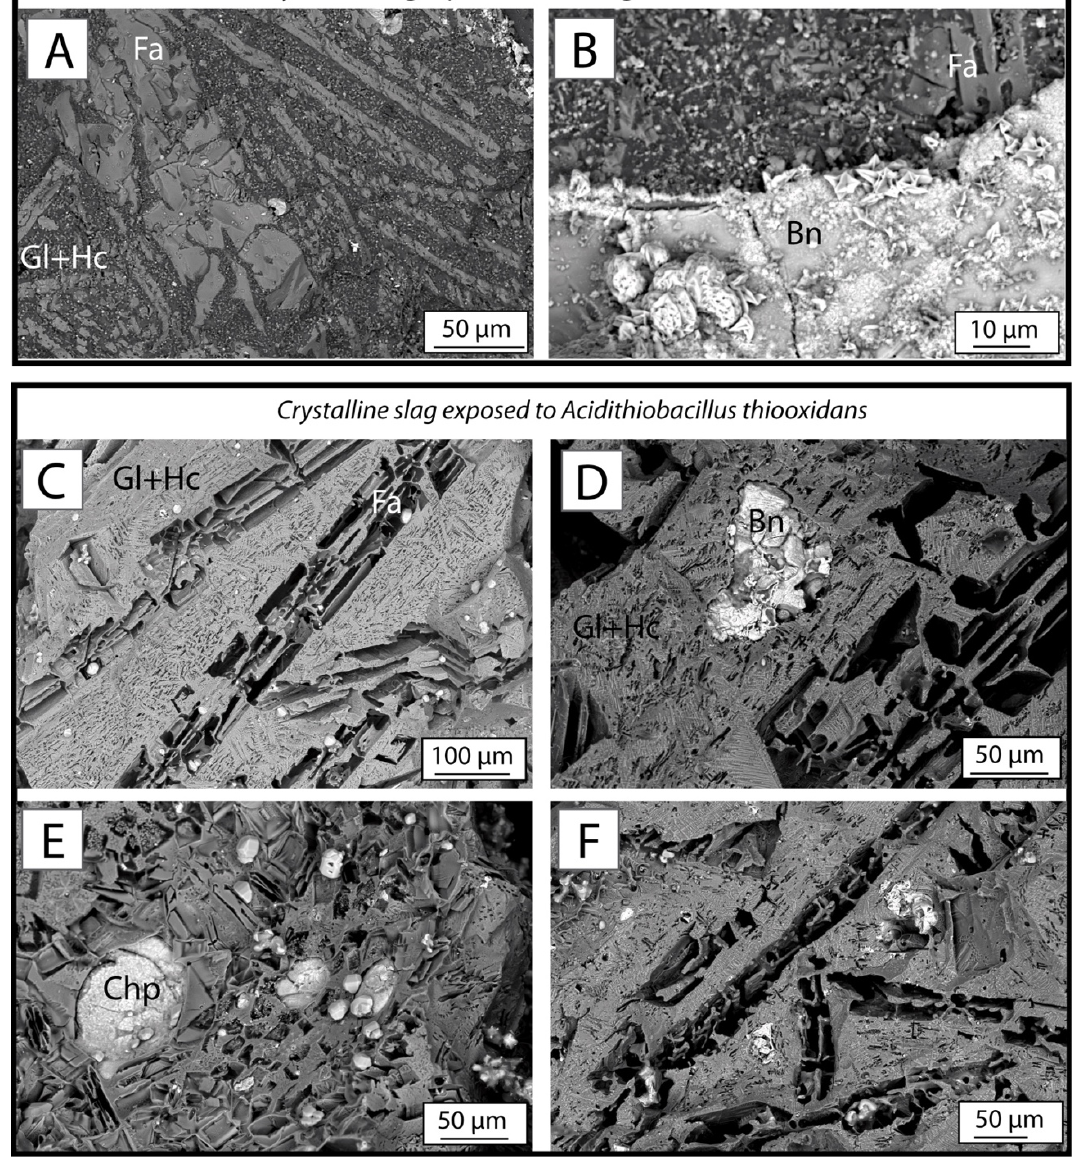
Figure 7. Scanning electron microscope images of CS leached during 21 days in abiotic growth medium and biotic solution with A. thiooxidans. Abbreviations: Fa: fayalite, Gl: glass, Hc: hercynite, Bn: bornite, Chp: chalcopyrite. ( A ) and ( B ): Crystalline slag exposed to abiotic growth medium; ( C–F ): Crystalline slag exposed to Acidithiobacillus thiooxidans .